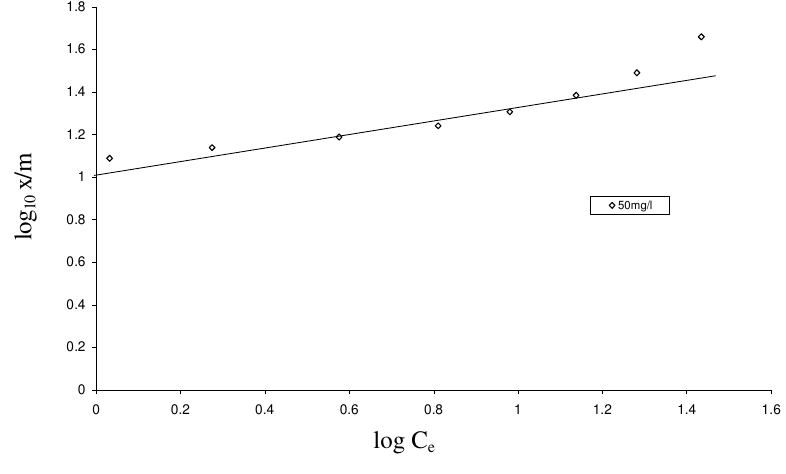
Figure 6. Freundlich plot for Cu (II)